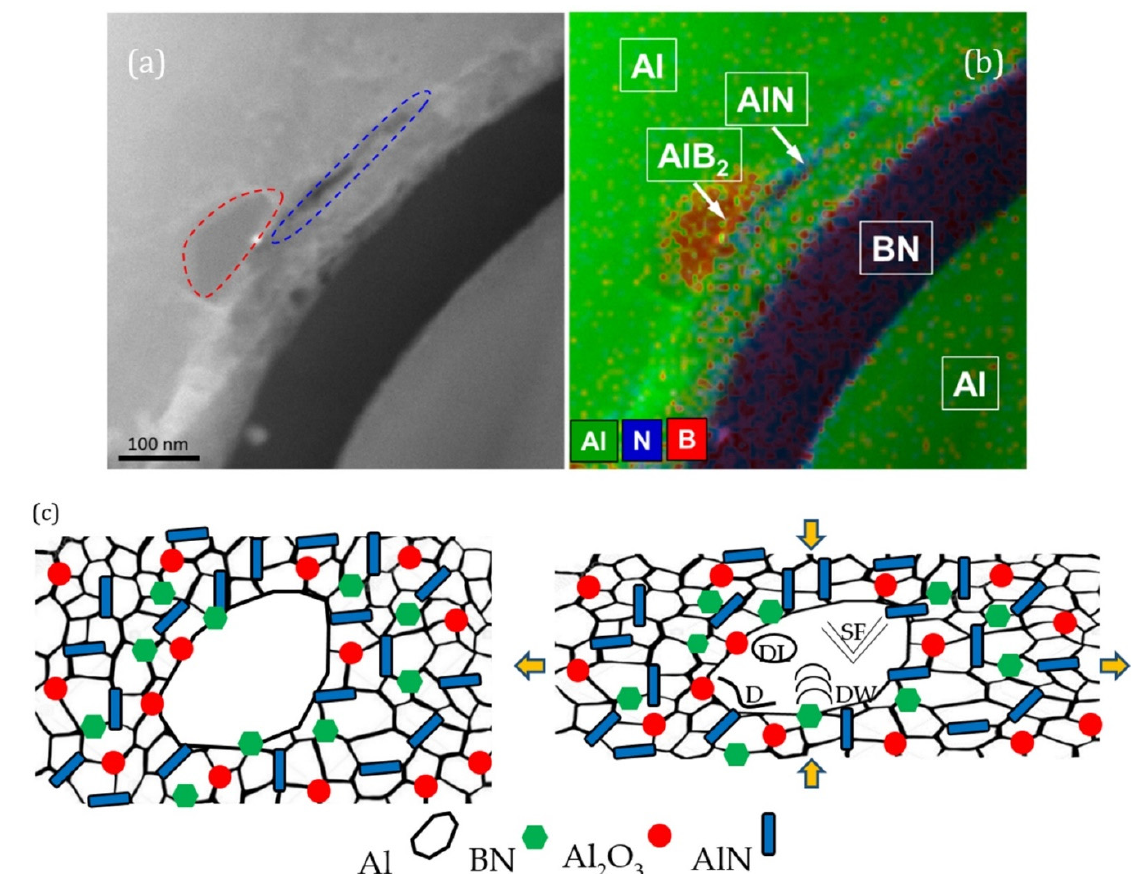
Figure 5. Formation of AlB 2 and AlN phases during SPS process. HAADF-STEM micrograph (red dash line outlines AlB 2 phase and blue dash line outlines AlN phase) ( a ) and corresponding spatially resolved EDXS map ( b ). Adapted with permission from Ref. [190]. Copyright 2019, Elsevier. Schematics of a two-level structure ( c ) consisting of micron Al grains surrounded by a composite material with nanosized Al grains and reinforcing nanosized AlN, Al 2 O 3 , and h -BN inclusions, which simultaneously provide high strength and ductility. D—Dislocation, DL—dislocation loop, SF—stacking fault, DW—dislocation wall. Adapted with permission from Ref. [187]. Copyright 2022, Elsevier.